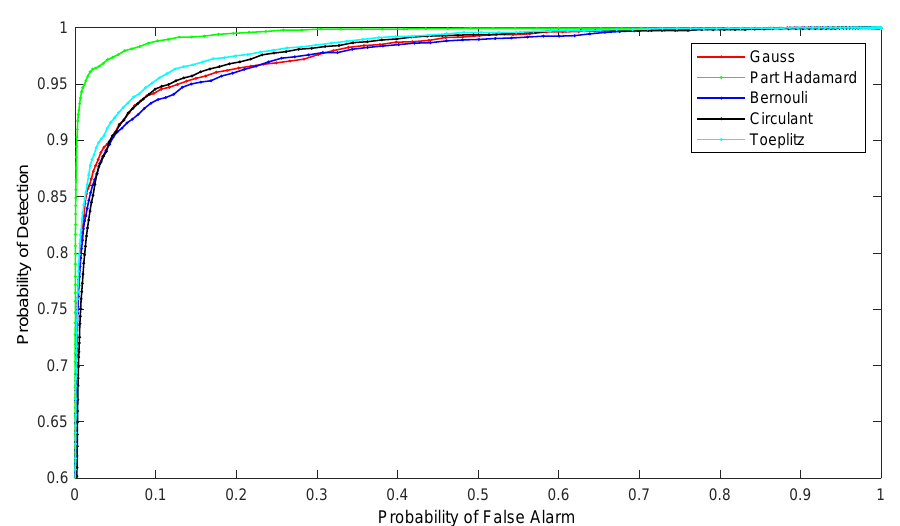
Table 2. Evaluation index of the subtraction image. Image